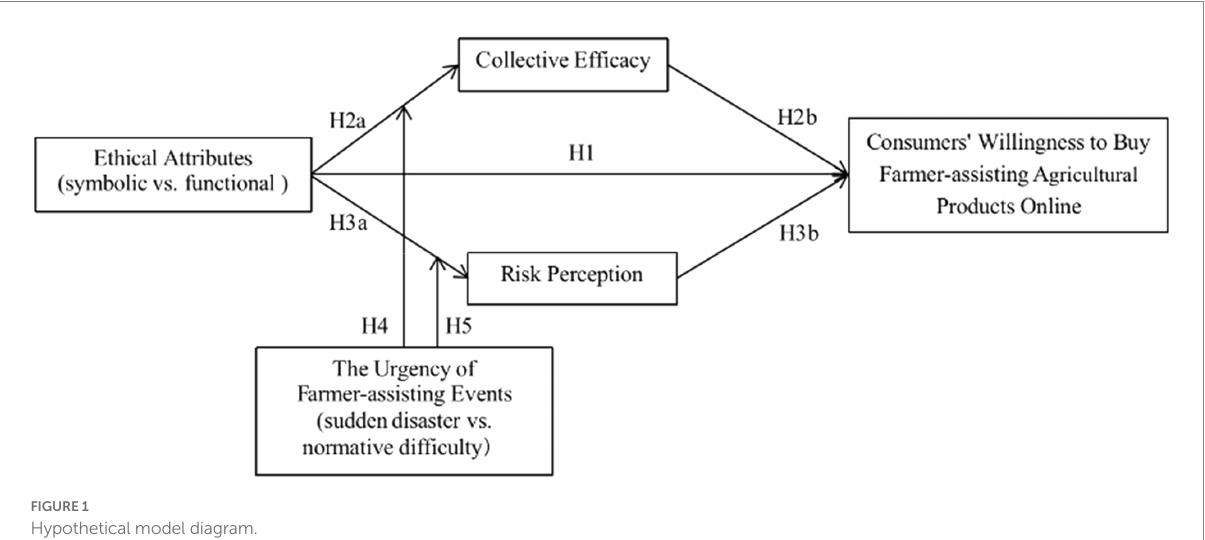
FIGURE 1 Hypothetical model diagram.